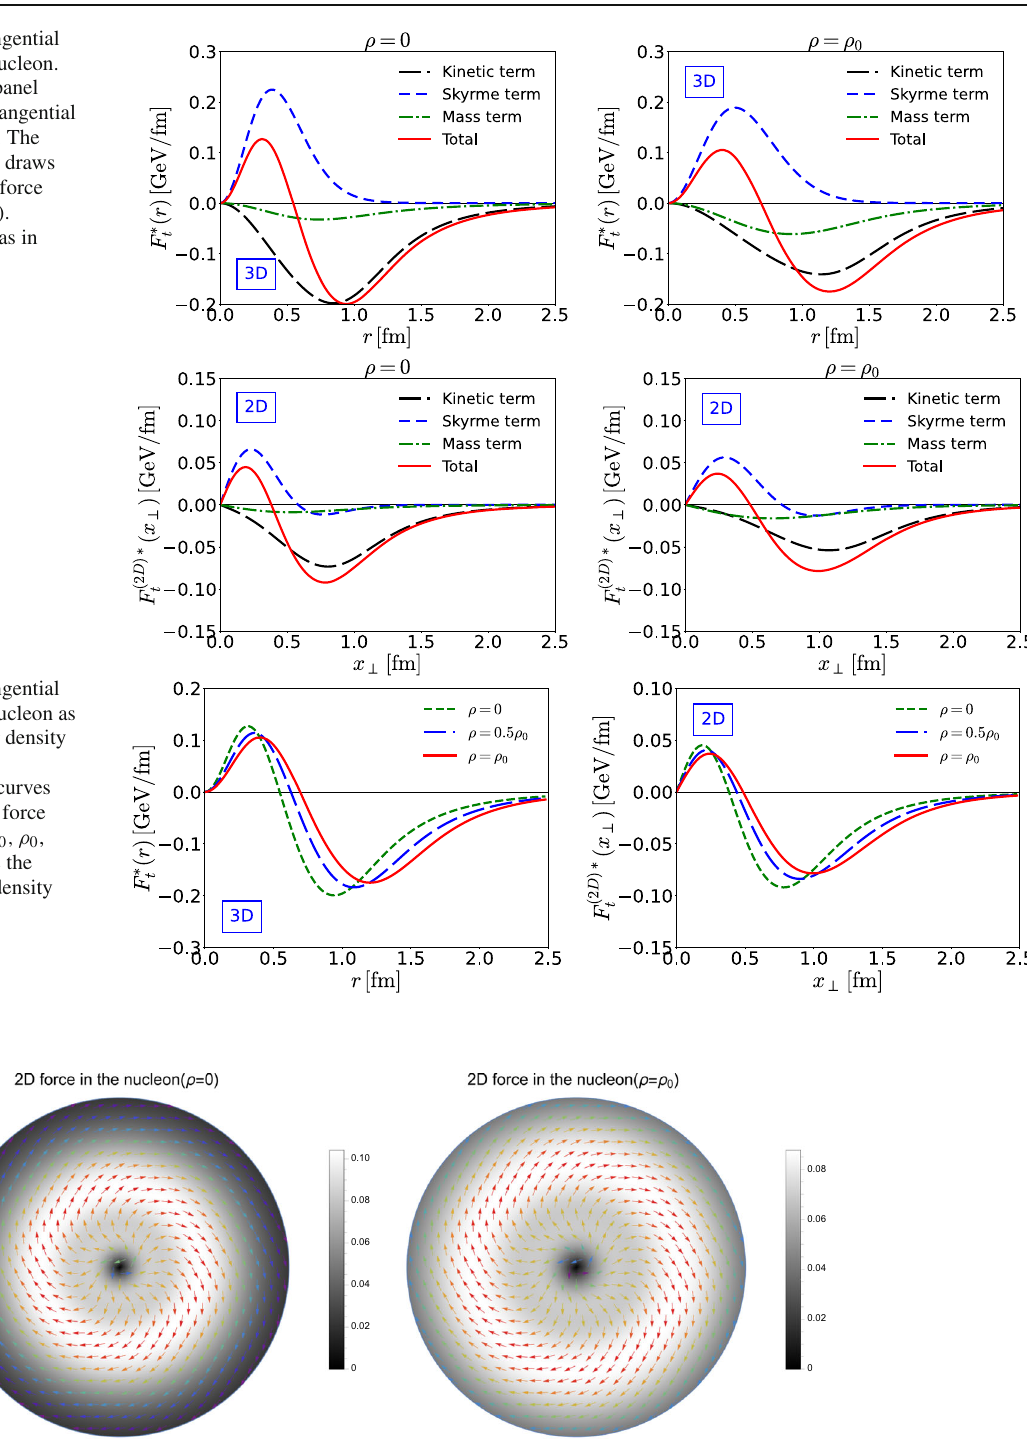
Fig. 12 Visualization of the 2D strong force field inside the nucleon. The left panel illustrates that in free space, whereas the right panel displays that in nuclear matter at the normal nuclear matter